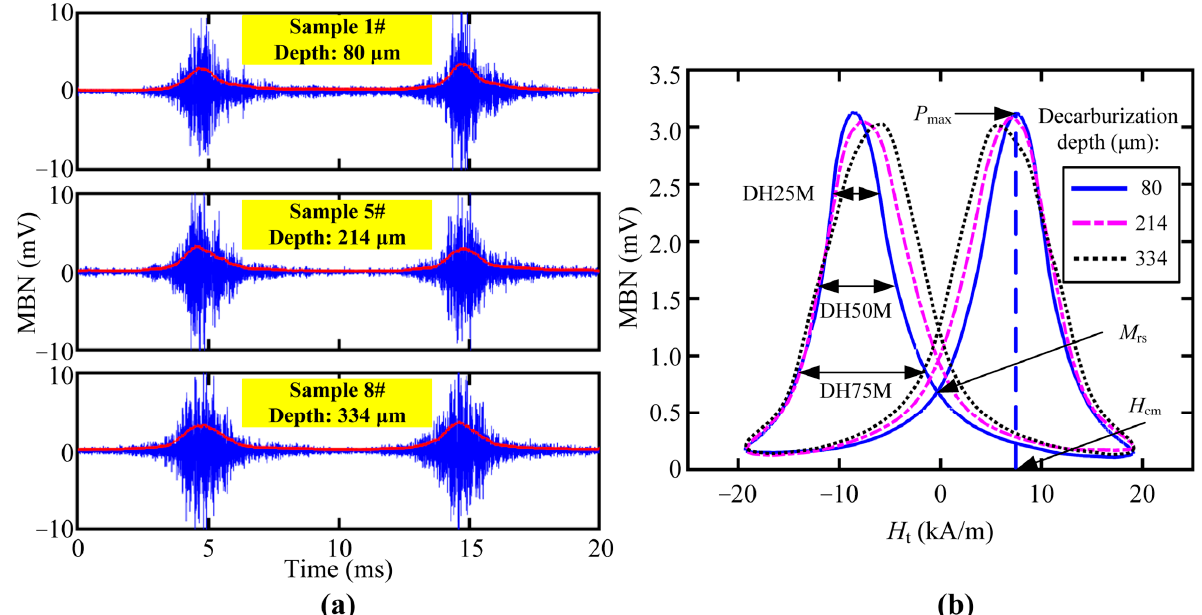
Figure 7. MBN test of the samples with a martensitic core: ( a ) waveforms of the MBN signals obtained from the samples with different decarburization depths and ( b ) calculated MBN butterfly profiles of the samples with different decarburization depths.